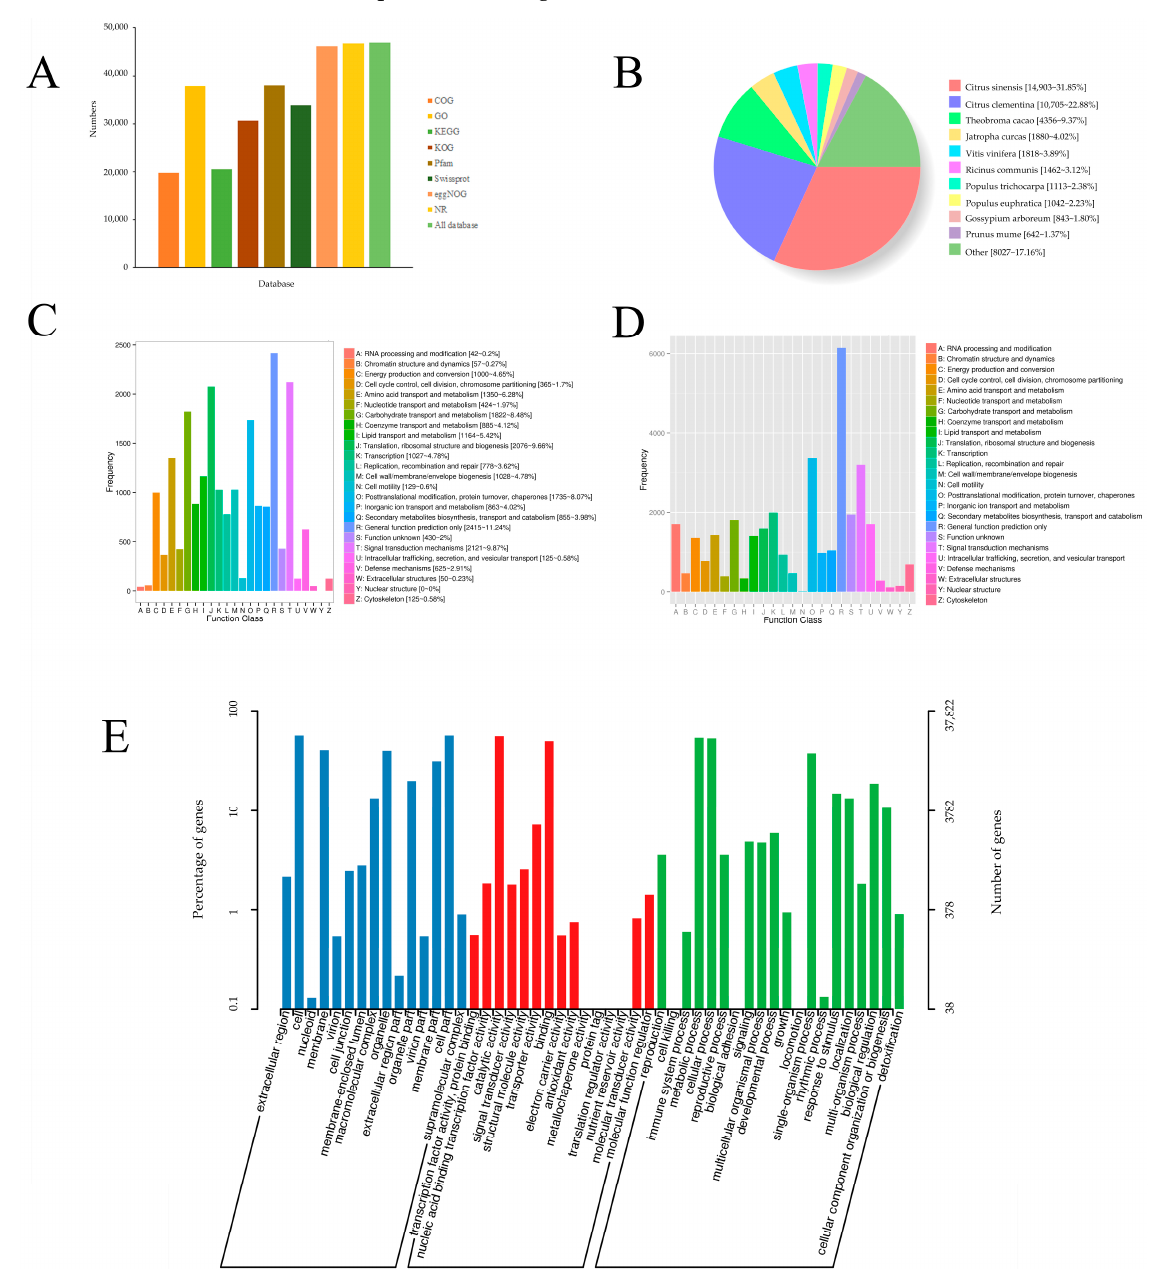
Figure 8. Functional annotation of the corrected transcripts: ( A ) Function annotation of N. sibirica transcripts in eight databases. NCBI non-redundant protein sequences database (NR); Protein family (Pfam); a manually annotated and reviewed protein sequence database (Swiss-Prot); Gene Ontology Consortium (GO); Cluster of Orthologous Groups of proteins (COG); Clusters of Orthologous Groups of proteins (KOG); evolutionary genealogy of genes: Non-supervised Orthologous Groups (eggNOG); and Kyoto Encyclopedia of Genes and Genomes (KEGG). ( B ) NR-annotated homologous species distribution. The best hits with an e-value = 10 − 6 for each query were grouped according to species. ( C ) COG annotation of transcript sequences. ( D ) KOG classification diagram of N. sibirica transcripts. ( E ) Classification of the all transcripts annotated by the